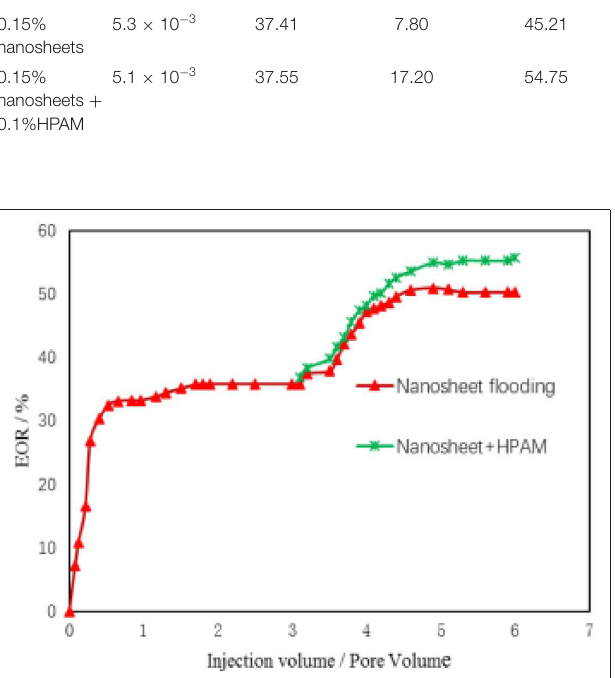
FIGURE 10 | Displacement effect curve.